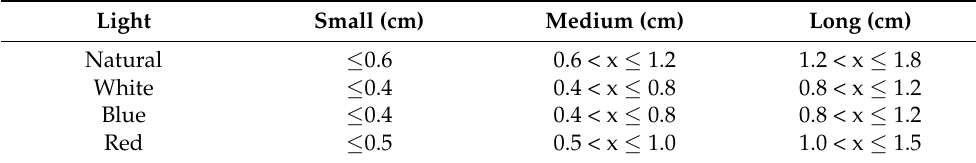
Table 3. Criteria dividing stem lengths into 3